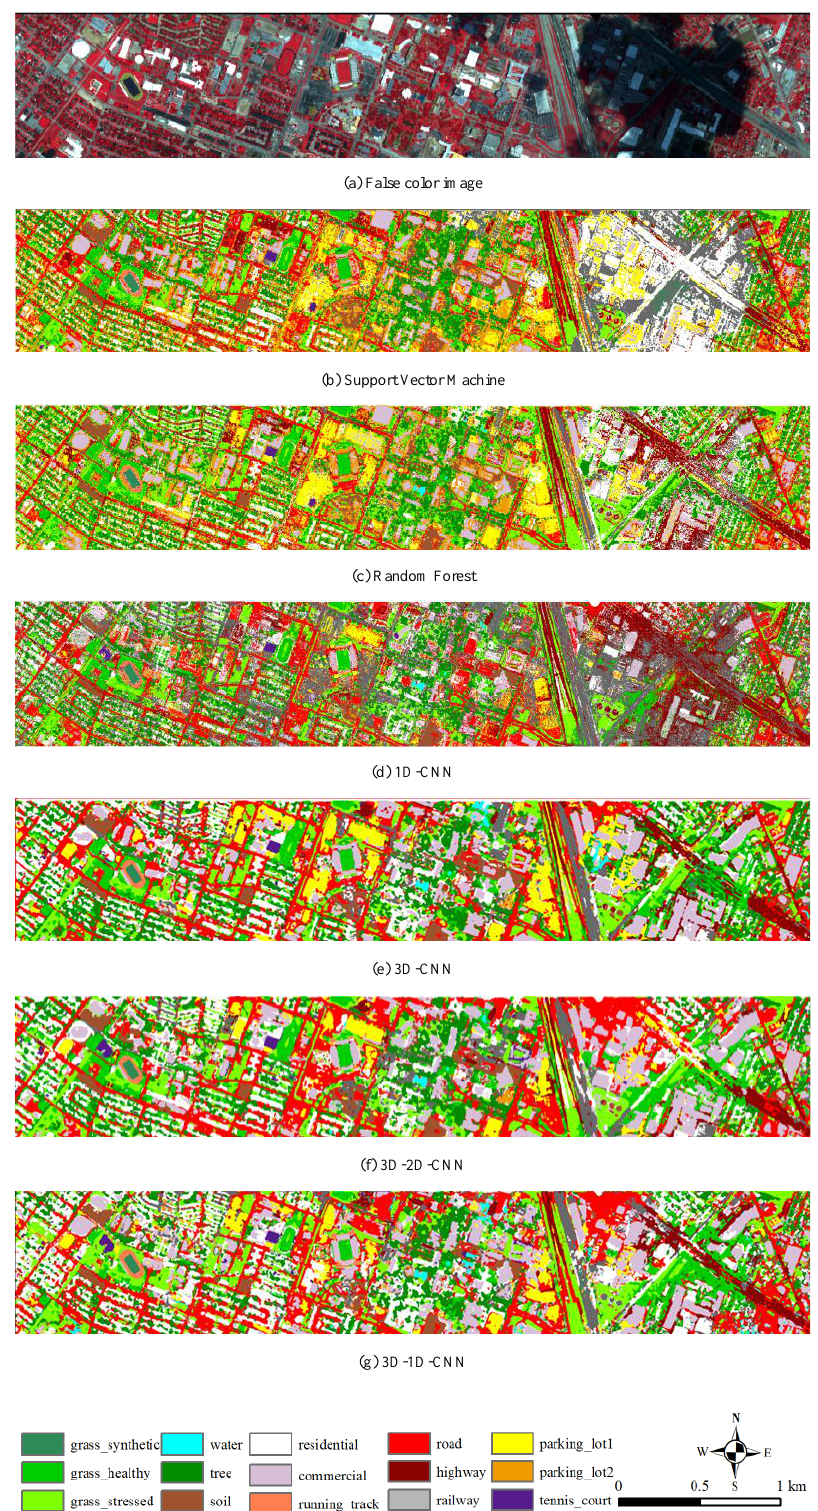
Figure 11. Classification results of different methods for Houston dataset with 15 classes. ( a ) False color image. ( b ) The classification map of SVM classifier, OA = 72.36%. ( c ) The classification map of RF classifier, OA = 85.30%. ( d ) The classification map of 1D-CNN classifier, OA = 91.10%. ( e ) The classification map of 3D-CNN classifier, OA = 95.90%. ( f ) The classification map of 3D-2D-CNN classifier, OA = 96.32%. ( g ) The classification map of 3D-1D-CNN classifier, OA =